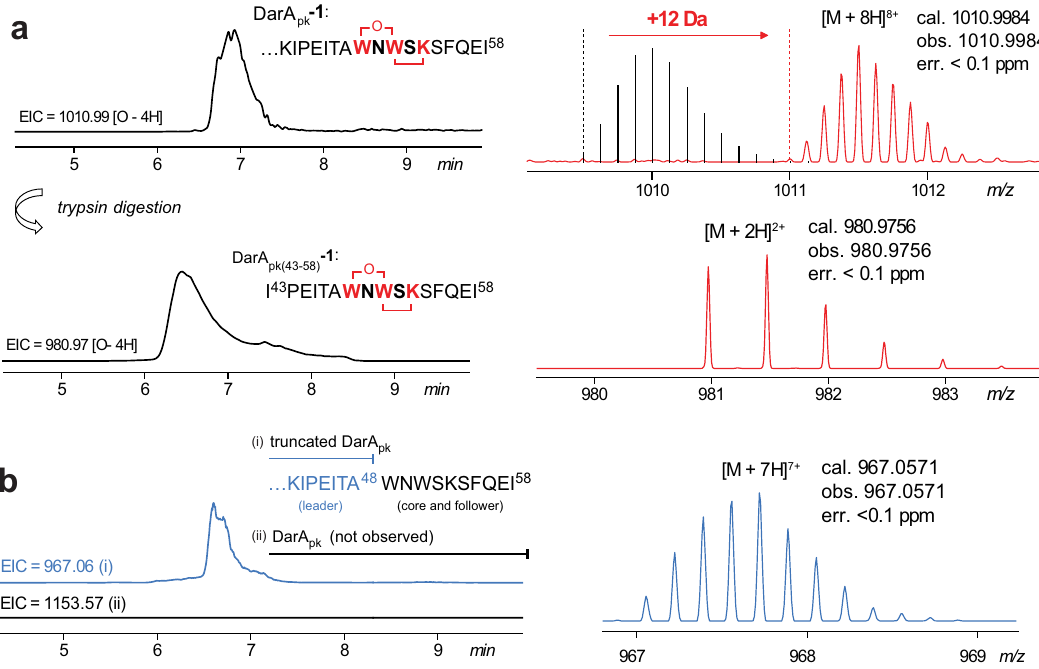
Fig. 2 LC-HRMS analysis of DarA pk produced in vivo, showing the extracted ion chromatograms (EICs) and MS spectra. a DarA pk produced by coexpression with DarE pk carries a + 12 Da modi fi cation. Because heterologous expression in E. coli only produced obtained the truncated DarA pk , the theoretically predicted signals corresponding to the unmodi fi ed DarA pk were shown for comparison. See Supplementary Fig. 3 for the HR-MS/MS spectrum of DarA pk(43-58) - 1 . b DarA pk produced by coexpression with the C86A mutant of DarE pk is a truncated peptide (i.e., DarA pk(1-48) ), which lacks the core and follower